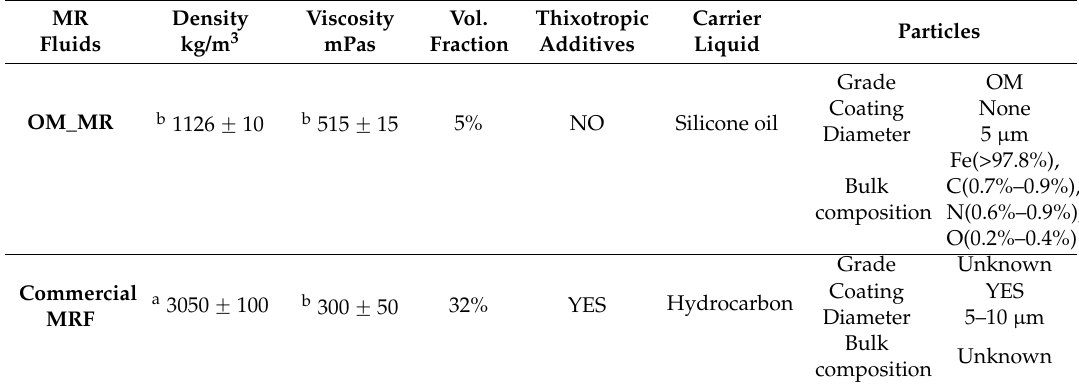
Table 1. Properties of the MR fluids used: OM MRF and Commercial MRF.